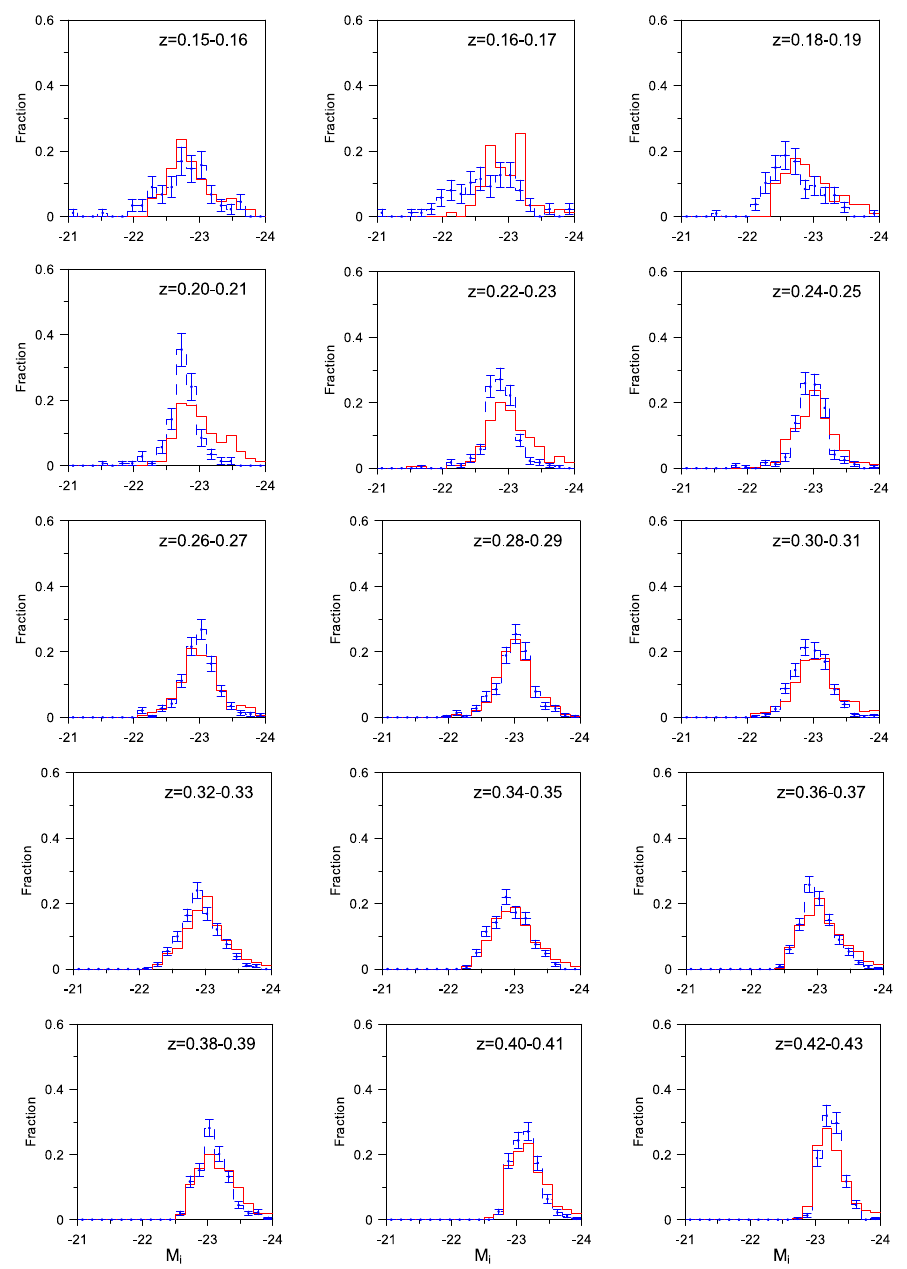
Fig. 4. Same as Fig. 1, but for the i -band absolute magnitude distribution at both density extremes in different redshift